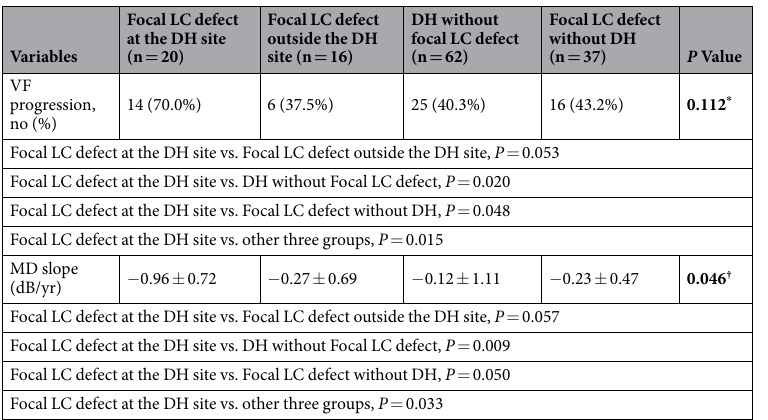
Table 5. Comparison of visual field progression in glaucoma patients with disc hemorrhage according to the findings of the lamina cribrosa and its relationship with the disc hemorrhage location. DH, disc hemorrhage; LC, lamina cribrosa; VF, visual field; MD, mean deviation. * Chi-square test. † Linear mixed-effect model. Factors with statistical significance are shown in